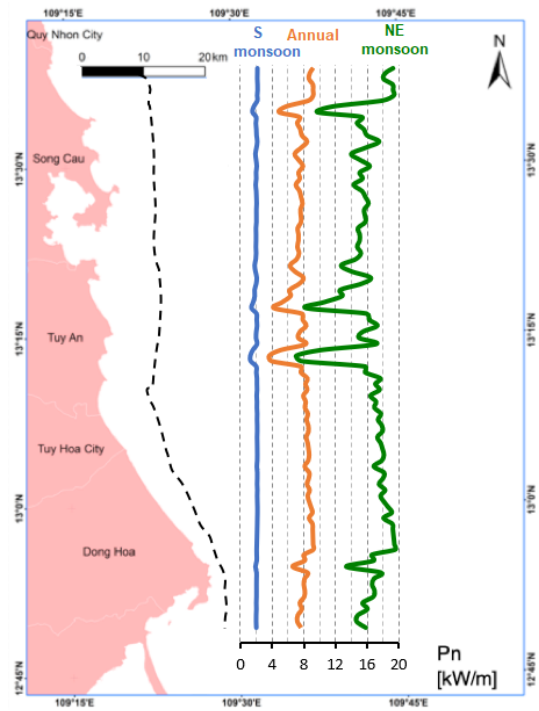
Fig. 6. Distribution of wave power along the 30-m contour depth [dashed curve] of Phu Yen coastline (annually-averaged and seasonally-averaged for S and NE